Question: From the figure, is the trend upward or downward?
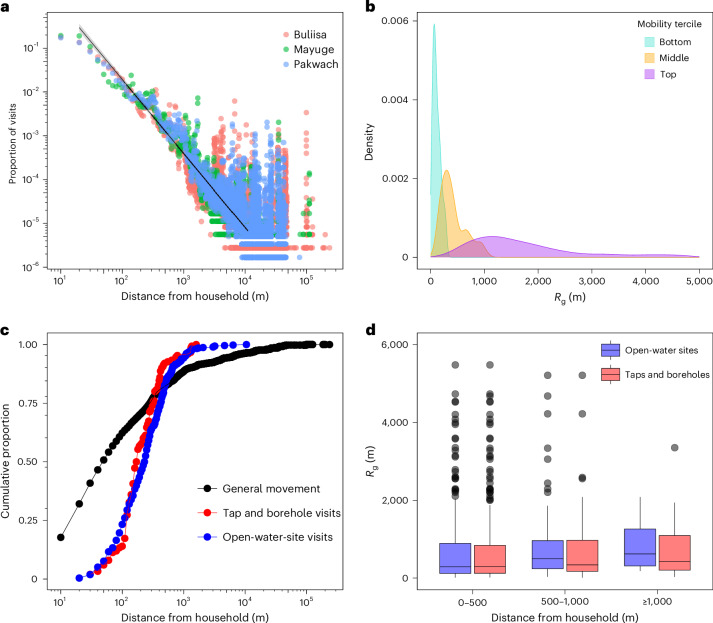
Answer: increasing